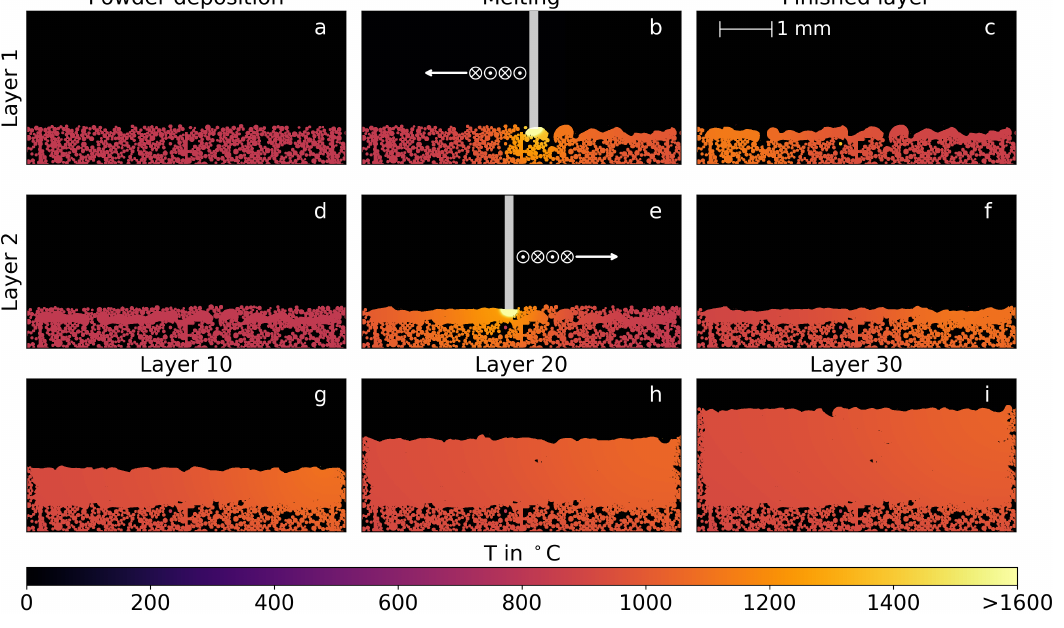
Figure 2. Temporal evolution of a simulated multi-layer building process. The deposited powder, the melting step, and the finished layer are shown for the first ( a – c ) and the second layer ( d – f ). Additionally, intermediate building heights after 10, 20, and 30 layers are illustrated ( h – i